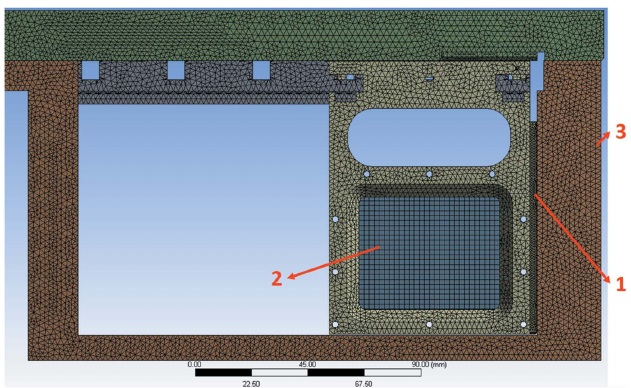
Figure 12 Simulation model and grid: (1) copper contact pad, (2) absorption foil (100 W), and (3) chamber cooling side (25 (cid:5) C). The total number of grid points is 1115215.